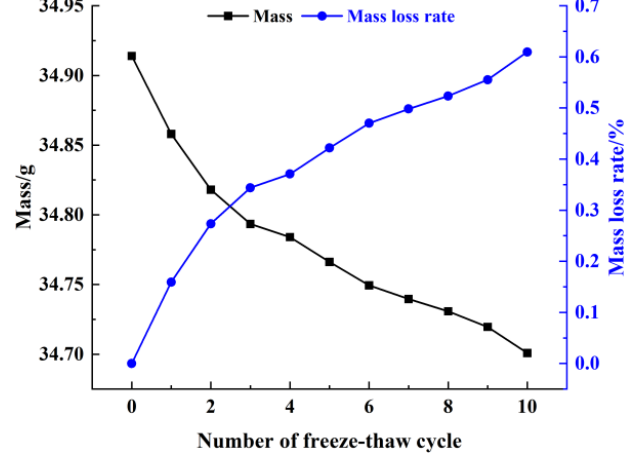
Figure 5. Freeze–thaw cycle effects on mass and mass loss rate.